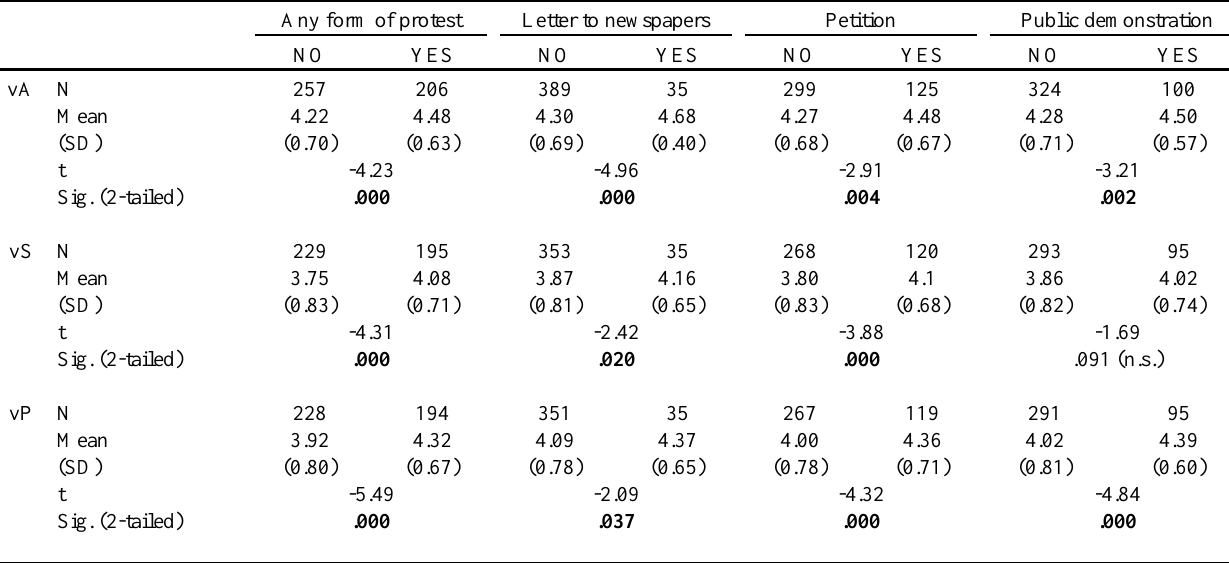
Table 2. Differences in vA, vS, and vP scores for different protest groups Any form of protest Letter to newspapers Petition Public